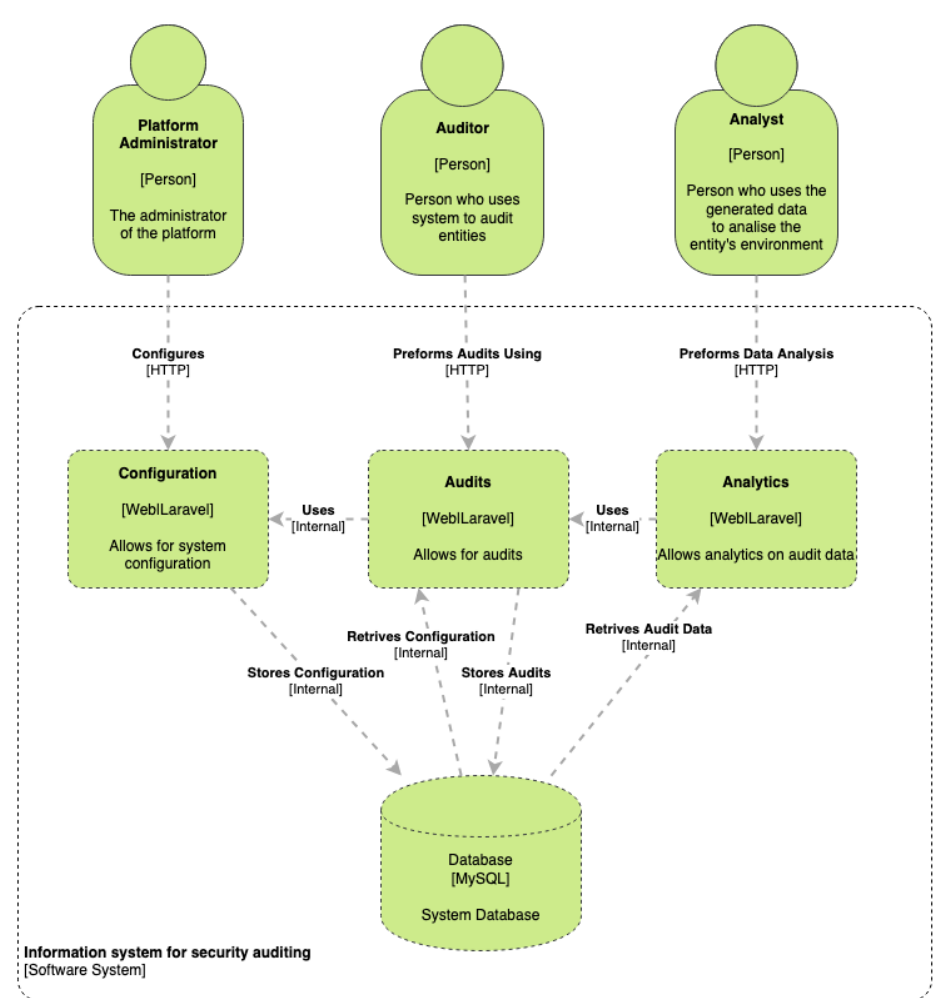
Figure 1. The C4 Level 2 diagram of the application